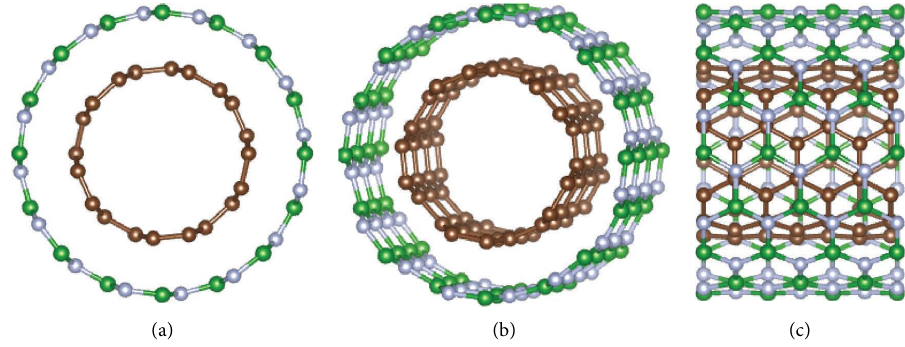
Figure 2: (a) Top view, (b) slanted view, and (c) side view of armchair CBNNT under 3.0nm